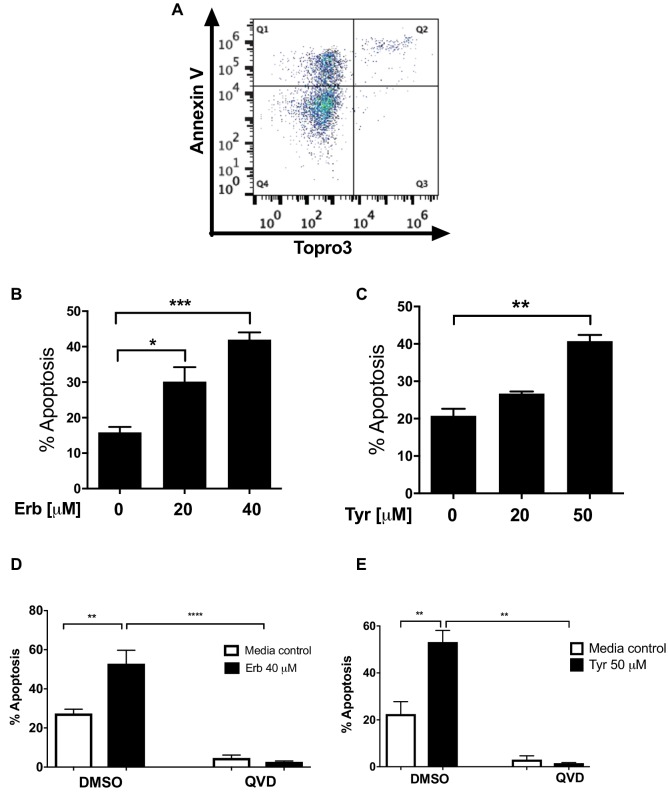
Erbstatin and tyrphostin AG825 induces caspase-dependent neutrophil apoptosis.Neutrophils were incubated with DMSO or 20 µM or 40 µM erbstatin (Erb, A and B) or tyrphostin AG825 (Tyr, C) for 6 hr. Apoptosis was assessed by Annexin V/TO-PRO-3 staining by flow cytometry and the percentage apoptosis calculated as Annexin V single plus Annexin V/TO-PRO-3 dual positive events. (A) Representative quadrant plot of Erbstatin-treated neutrophils showing distribution of Annexin V and TO-PRO-3 positive events. (D–E) Neutrophils were incubated with DMSO or Erbstatin [40 µM] in the presence or absence of the pan caspase inhibitor, Q-VD-OPh [1 µM] for 6 hr (D) or 20 hr (E). Apoptosis was assessed by light microscopy. The data are expressed as mean percentage apoptosis ± SEM from 3 (B), 4 (C and E), or 5 (D) independent experiments. Statistical differences were calculated by one-way ANOVA (with Dunnett’s post test (B–C) and two-way ANOVA with Sidak (D–E) post-tests) and indicated as *p≤0.05, **p≤0.01, ***p≤0.001, ****p≤0.0001.